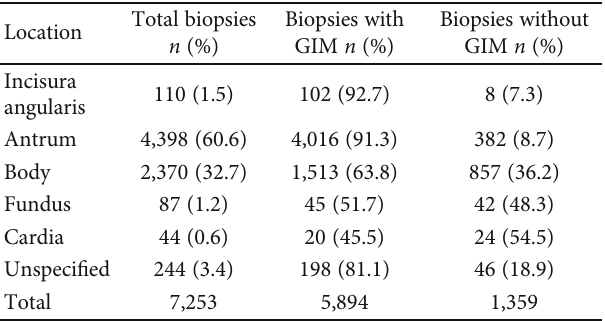
Table 2: Biopsy location distribution during the study period (2012-2014). Location